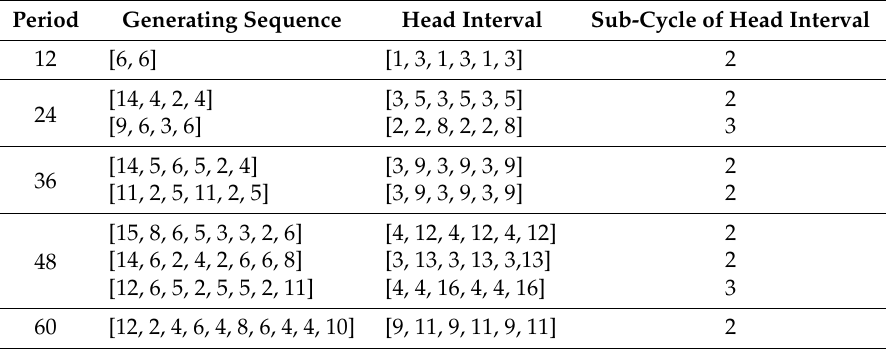
Table 1. New STGCs with non- k -spaced heads in the complete searching result of length-6